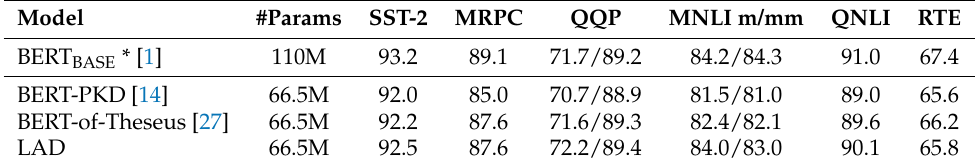
Table 2. Results of the six-layer student models from the GLUE test server. Two evaluation metrics with a slash (F1/accuracy scores) are reported for QQP, and accuracy scores are reported for the other tasks.